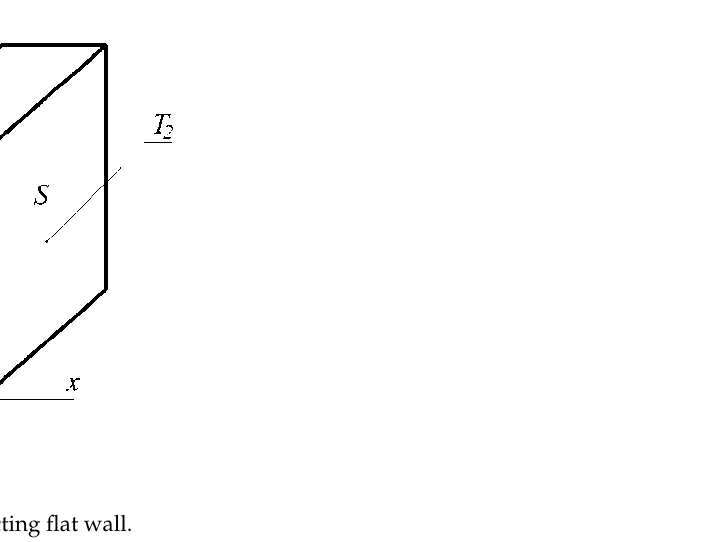
Figure 6. Heat conducting flat wall.